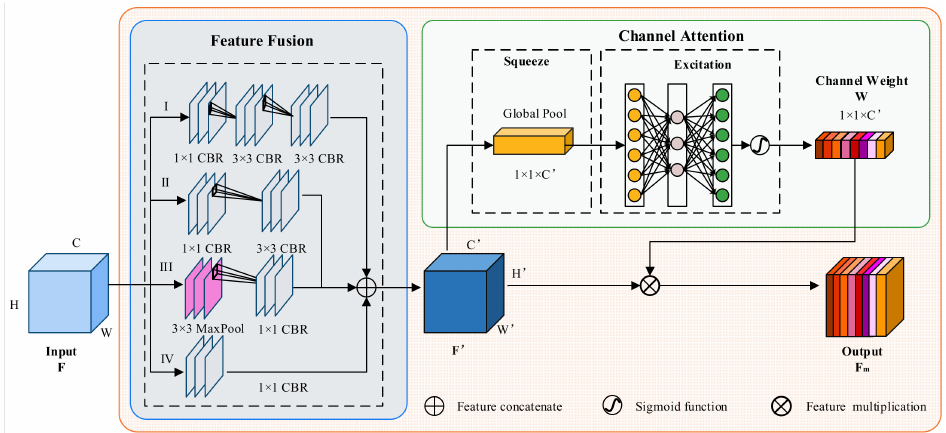
Figure 5. Structure of a multi-scale feature extraction